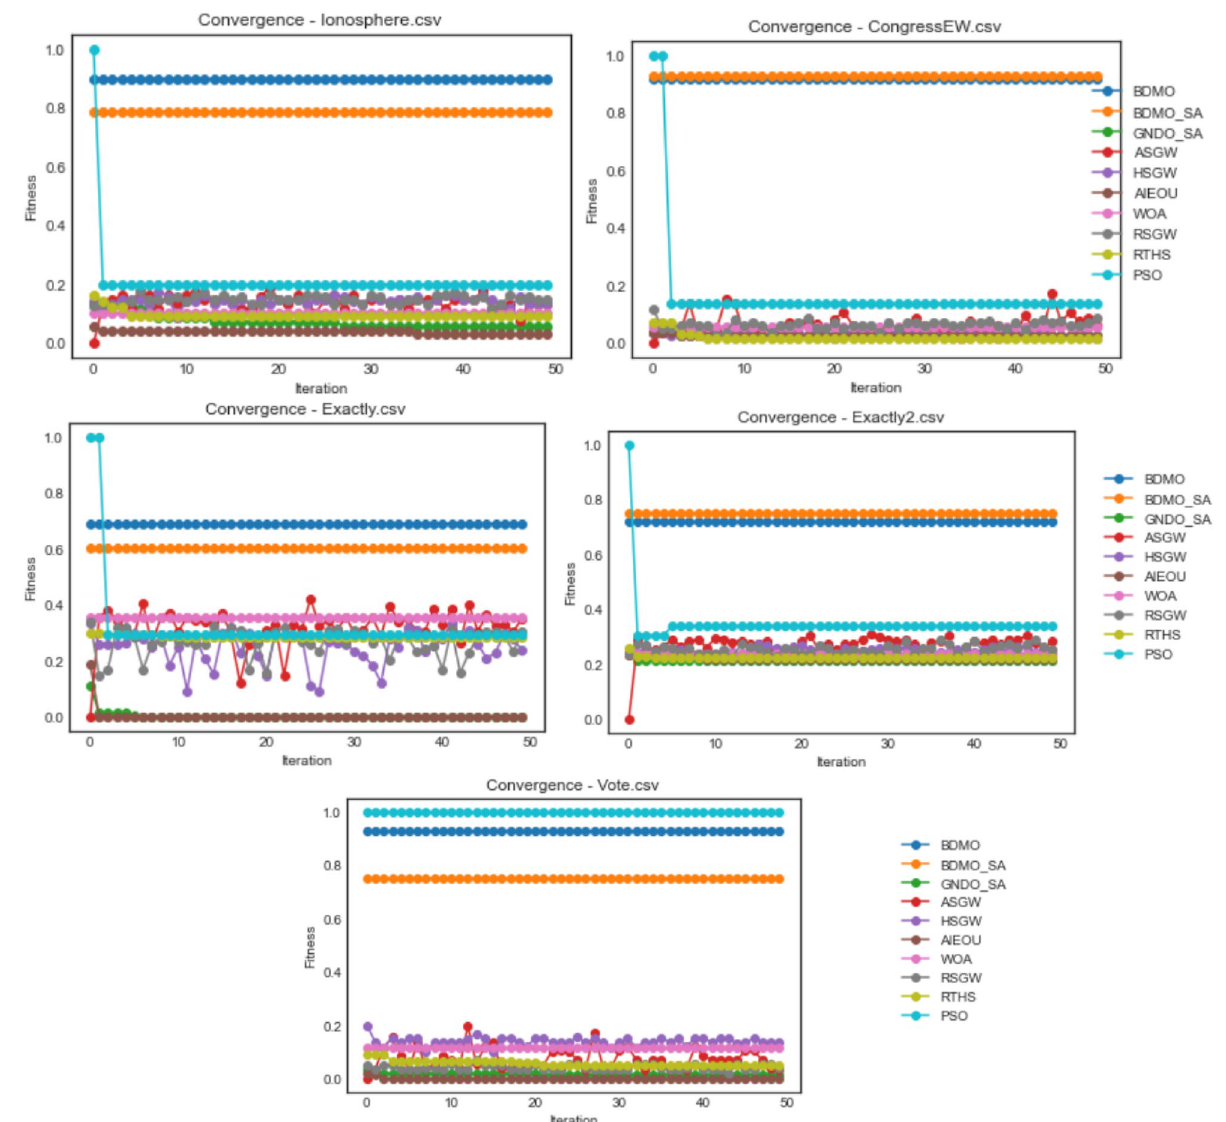
Figure 2. Convergence behavior of all algorithms on the ionosphere, congressEW, Exactly, Exactly2, and Vote datasets.